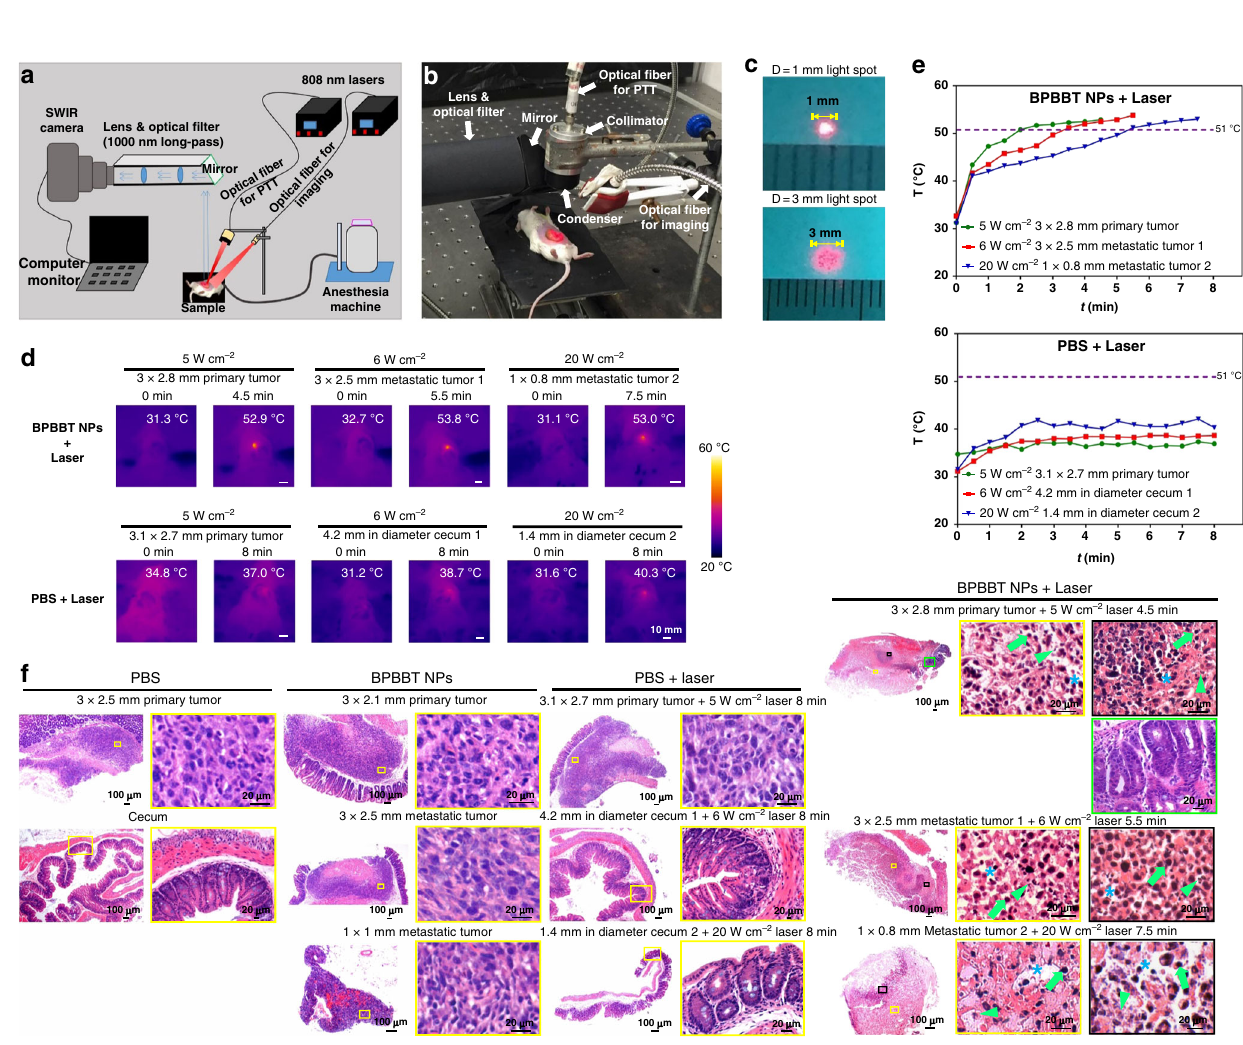
Fig. 8 Validation of intraoperative NIR-II image-guided cancer PTT with BPBBT NPs. a Schematic illustration of home-made system for NIR-II image-guided PTT of tumor in mice. b Photograph of NIR-II image-guided PTT of BALB/c mice bearing orthotopic CT26 colon cancer under anesthetic condition. c Measurement of laser spot adjusted to 1 mm or 3 mm in diameter for PTT. d Infrared (IR) thermal images before (0 min) and at the end of PTT of the tumor-bearing mice at 30 h following i.v. injection with BPBBT NPs (20 mg kg − 1 ) or PBS. In the BPBBT NPs-treated mice, primary and metastatic tumor was identi fi ed under NIR-II imaging followed by PTT with the indicated laser power density. In the PBS group, primary tumor was visualized by eye. Due to the invisible metastatic lesions, areas of cecum next to the primary lesion were randomly selected for PTT. e Temperature of the irradiated area-time curves from the IR thermal imaging of ( d ). f H&E staining of tumor or normal cecum of mice at 24 h following different treatment. In the BPBBT NPs-treated mice, primary and metastatic tumor was visualized under NIR-II imaging. In the PBS group, primary tumor was visualized by eye, while the metastatic lesions were invisible. Area of normal cecum was randomly selected. Tumor necrosis was characterized by extensive pyknosis (arrows), karyolysis (arrowheads), cytoplasmic acidophilia, and degradation of the extracellular matrix of tumor